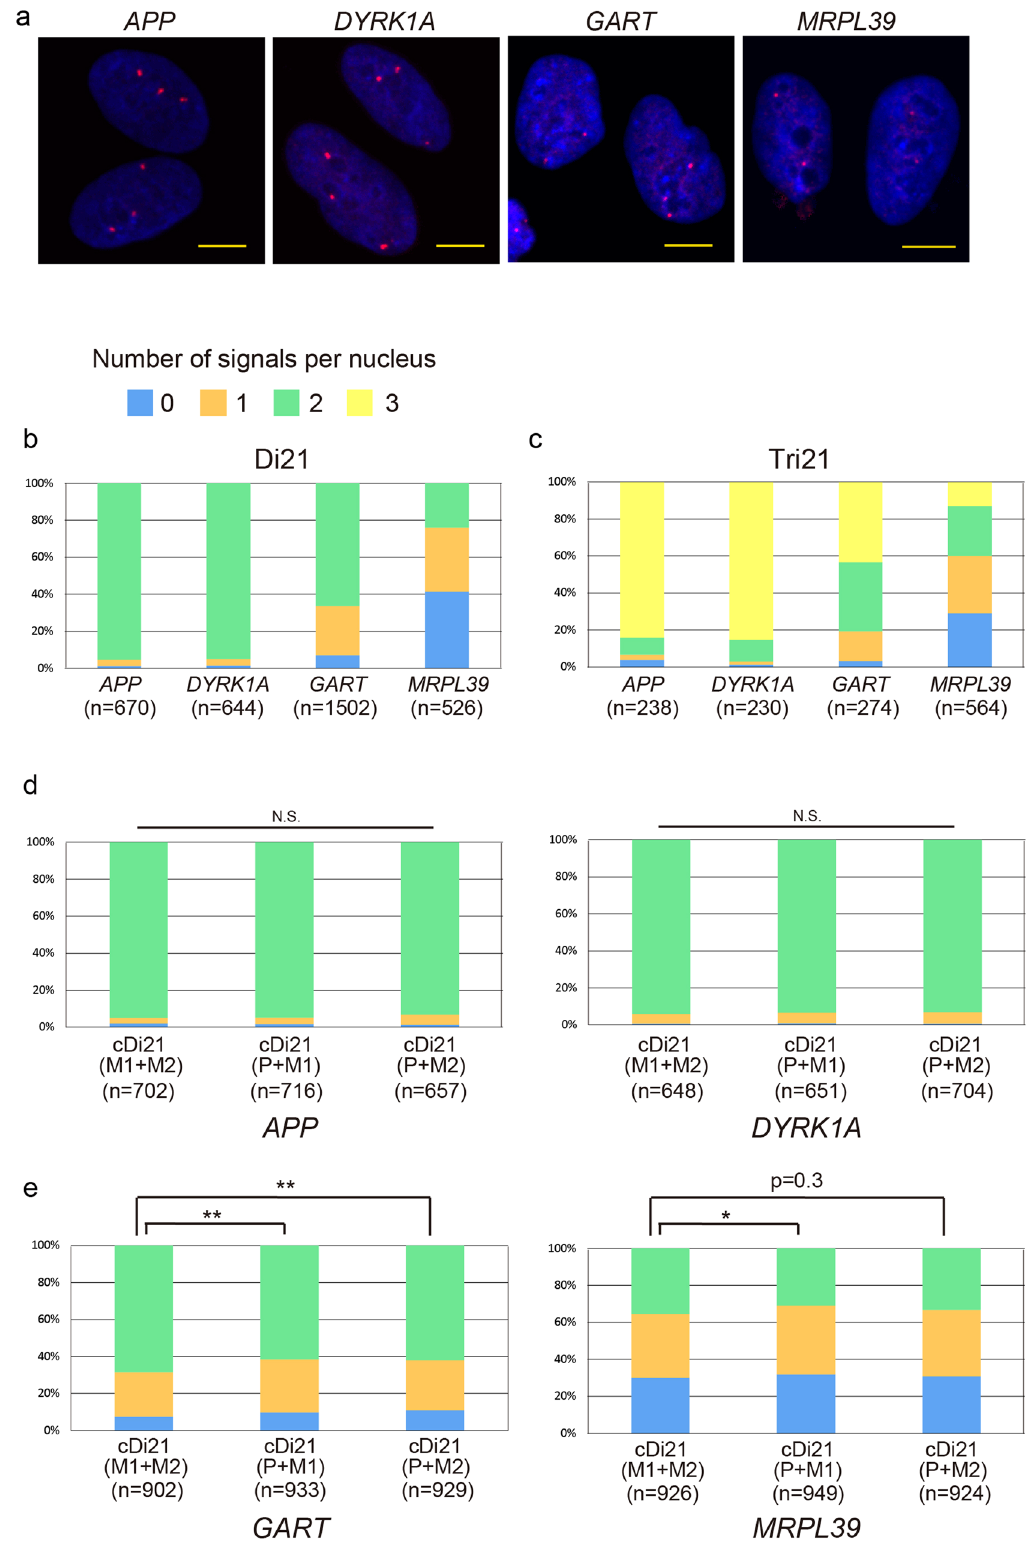
Figure 6. Transcriptional profiling of the genes on HSA21. ( a ) Nascent RNA FISH of each gene in Tri21 iPSCs. RNA was labelled with red probe. Nuclei were stained with DAPI. Scale bars represent 10 μ m. ( b–e ) Number of RNA signals per nucleus in ( b ) Di21, ( c ) Tri21 and ( d,e ) cDi21 iPSCs. Error bars represent SEM. p values were determined by the chi-squared test. * p < 0.05, ** p <